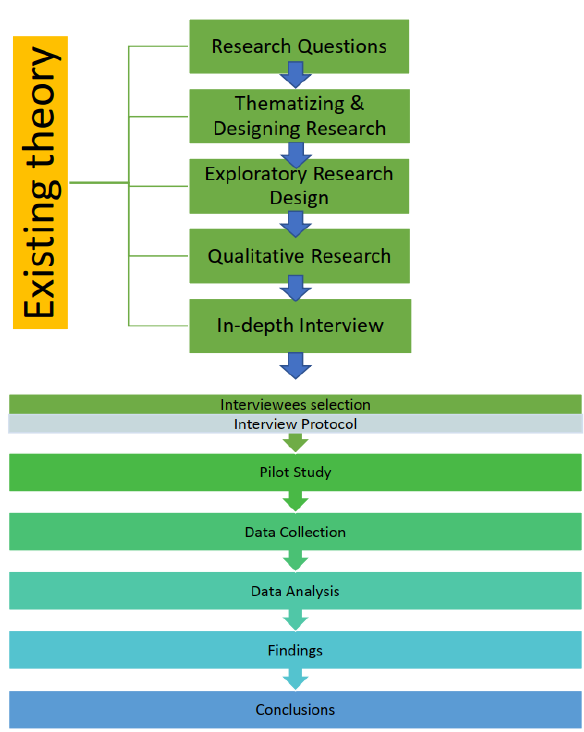
Figure 1. Research design conceptual framework.